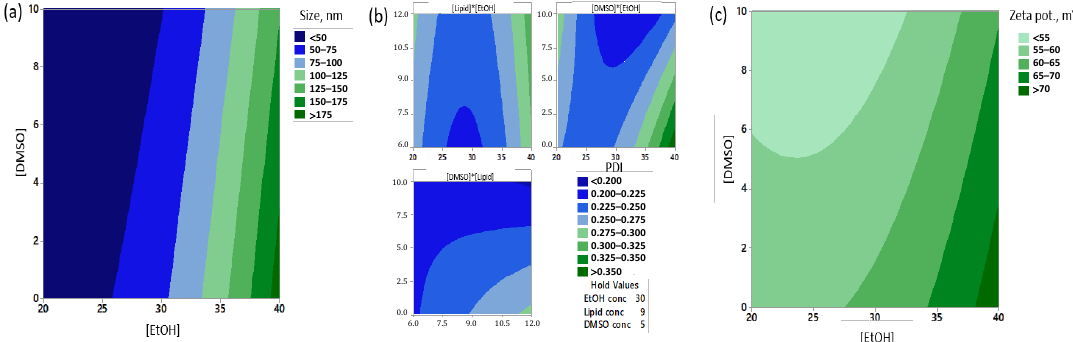
Figure 1. Modeling of physicochemical data for formulations at the day of manufacture (day 0) from design of experiments were analyzed using face-centered response surface methodology to evaluate the e ff ects of the parameters [EtOH], [Lipid], and [DMSO]. Contour plots for the read outs for ( a ) particle size, lack-of-fit p = 0.177, adj. r 2 = 97.62%, ( b ) polydispersity indexes (PDI), lack-of-fit p =